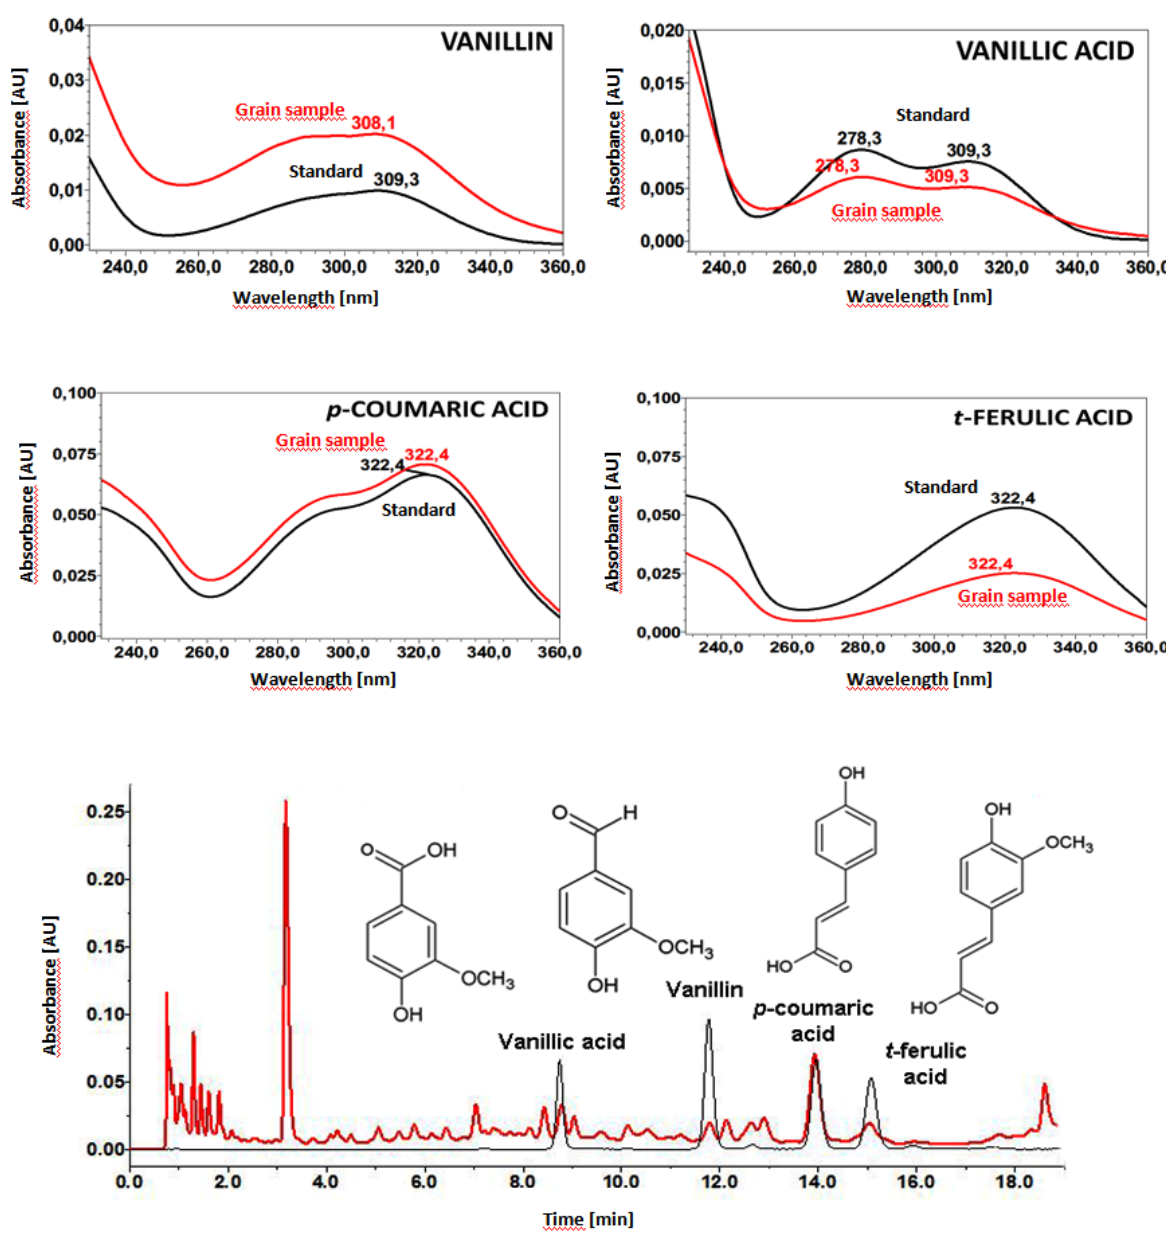
Figure 1: Overlay of UV-spectra of four phenolic compounds (black lines – standards, red line – grain sample) and two chromatograms (black line – standard mixture, red line – grain sample of genotype Tetra